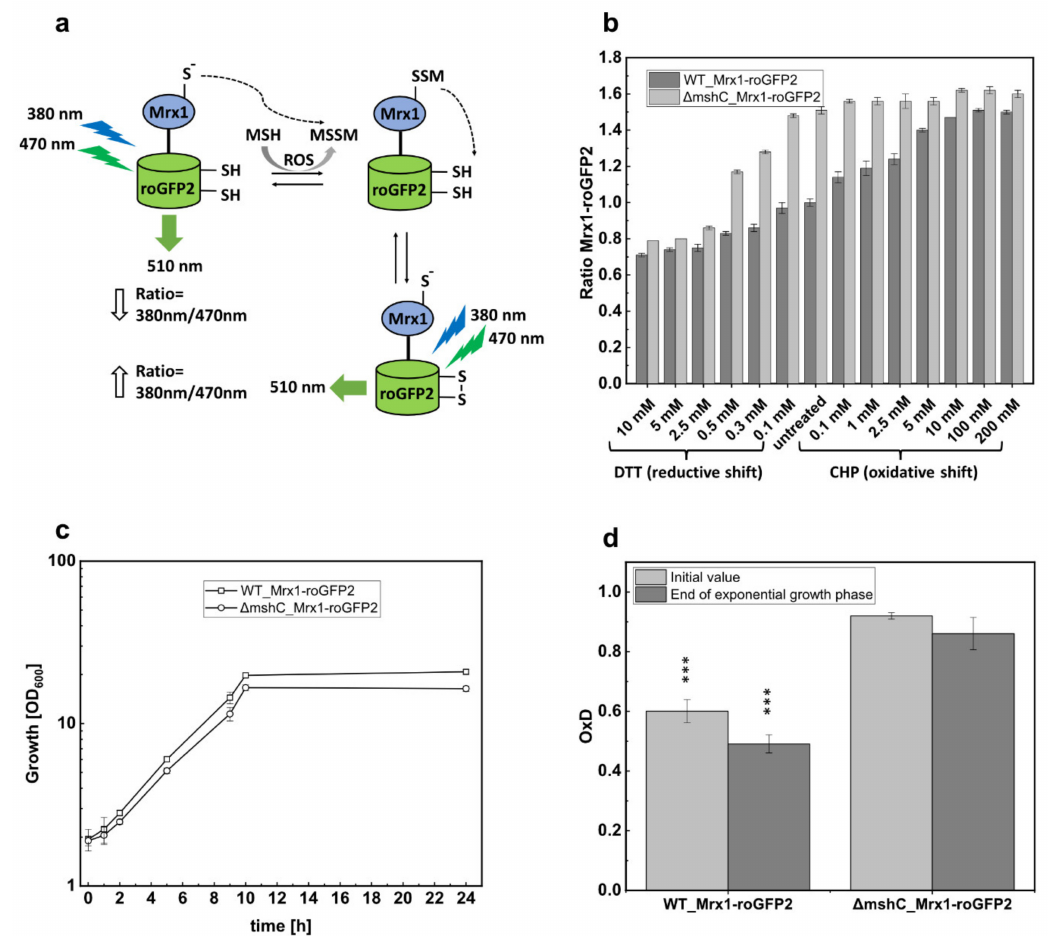
Figure 2. Schematic illustration of the Mrx1-roGFP2 biosensor response mechanism ( a ); the ratiometric Mrx1-roGFP2 biosensor response as shown by the 380 / 470 nm excitation ratio upon treatment with di ff erent concentrations of reductants (DTT) and oxidants (CHP) in C. glutamicum WT_Mrx1-roGFP2 (WT_Mrx1-roGFP2) and C. glutamicum ∆ mshC _Mrx1-roGFP2 ( ∆ mshC _Mrx1-roGFP2) ( b ); shake flasks cultivations of WT_Mrx1-roGFP2 and ∆ mshC _Mrx1-roGFP2 in 50 mL CGXII minimal medium (T = 30 ◦ C, initial glucose concentration 15 g L − 1 , 150 rpm) ( c ); and biosensor oxidation degrees (OxD) derived from shake flask samples after inoculation and the end of exponential growth phase ( d ). Errorbarsindicatestandarddeviationsfromthreeindependentexperiments.OxDvalueswerecalculated by normalizing the samples to fully oxidized and reduced controls. OxD values of WT_Mrx1-roGFP2 are significantly di ff erent when compared with ∆ mshC _Mrx1-roGFP2 OxD values at the p = 0.01 level (one-way analysis of variance (ANOVA) with Tukey´s test) ( *** p < 0.0001). MSH, mycothiol; ROS, reactive oxygen species; MSSM, mycothiol